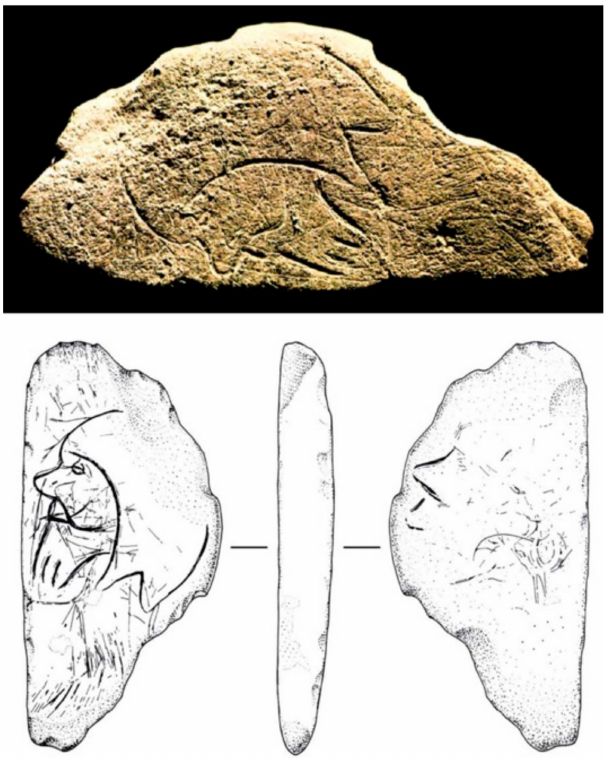
Figure 3. Image and drawings of the limestone slab of the “Uomo barbuto di Vado